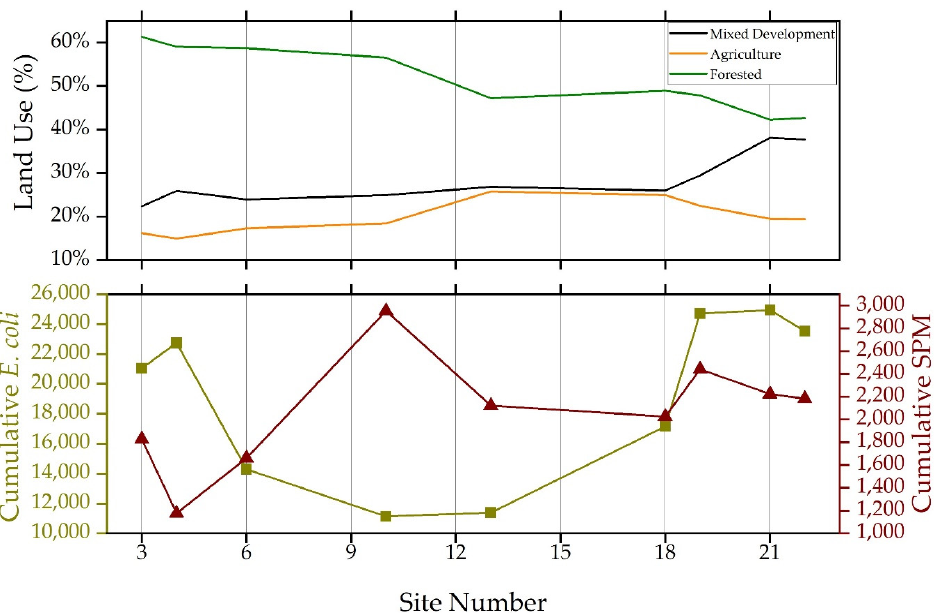
Figure 6. Land use percentage relative to cumulative annual E. coli concentration (CFU per 100 mL) and SPM concentration (mg/L) at West Run Creek monitoring sites (n = 9) during the study period (2 January 2018–1 January 2019) in West Run Watershed, Morgantown, West Virginia, USA. Note: West Run Creek included the following site numbers: #3, #4, #6, #10, #13, #18, #19, #21 and #22.